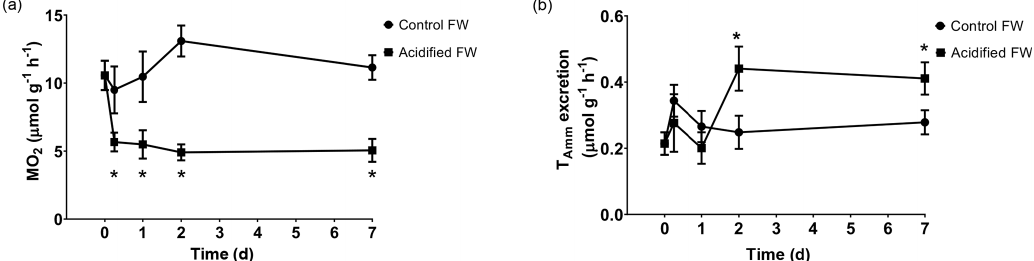
Figure 3. Changes in whole-animal (a) oxygen consumption rate (MO 2 ) and (b) ammonia excretion rate of juvenile Chinese mitten crabs, Eriocheir sinensis , during a 7d time course of exposure to control (pH 7.41, 1299µatm p CO 2 ) or CO 2 -acidified (pH 6.73, 5109µatm p CO 2 ) freshwater. Data are presented as mean ± SEM. ( N = 5–6 for oxygen consumption and N = 7–12 for ammonia excretion). Statistical significance was assessed by two-way ANOVA followed by a post hoc Dunnett test. Significant differences from day zero measurements are indicated by ∗ . p values near but not < 0 . 05 are written above the corresponding data